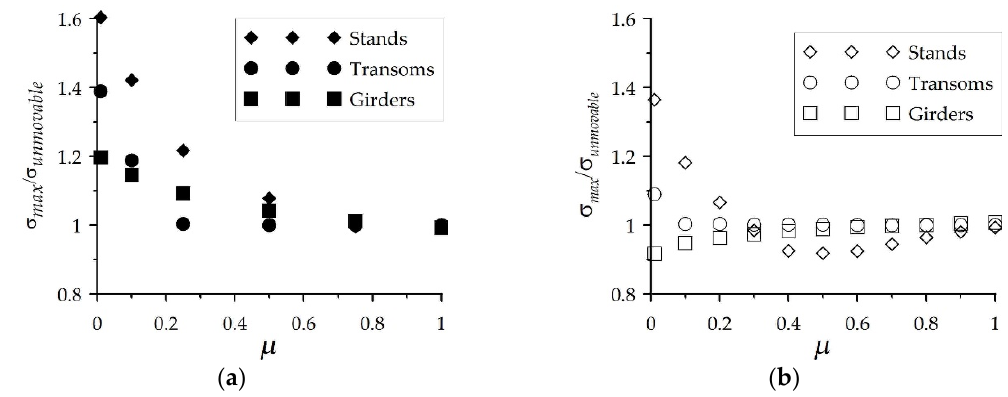
Figure 9. Extreme normal stresses depending on the μ value with ground heterogeneity in a direction: perpendicular to the facade ( a ); parallel to the façade ( b )